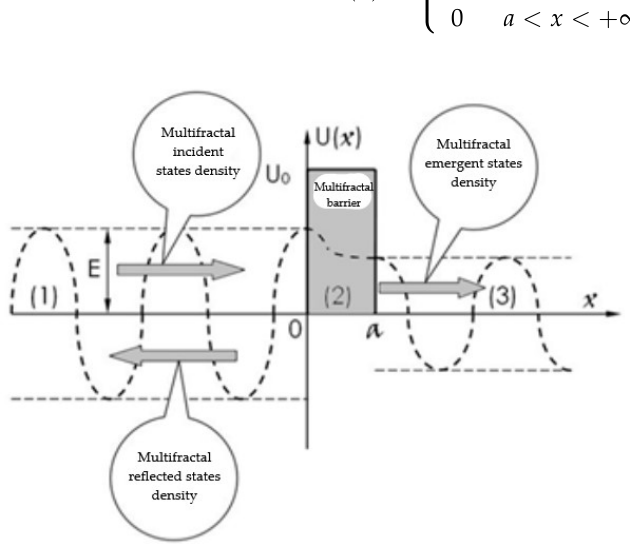
Figure 1. Multifractal barrier—SMA system describing the tunnel effect